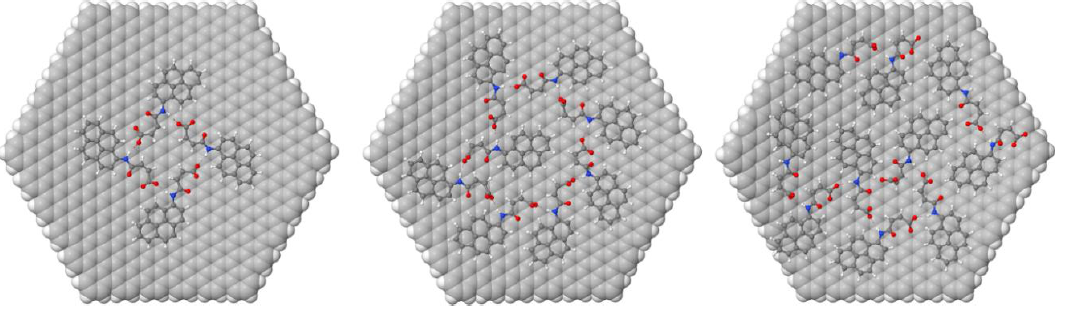
Figure 9. Models with four, eight, and 10 deprotonated PY molecules adsorbed on a graphene monolayer flake at the GFN-xTB level. The graphene flake is represented by an array of carbon spheres, and the PY molecules are shown with the ball and stick representation. Nanomaterials 2018 , 8 , x FOR PEER REVIEW